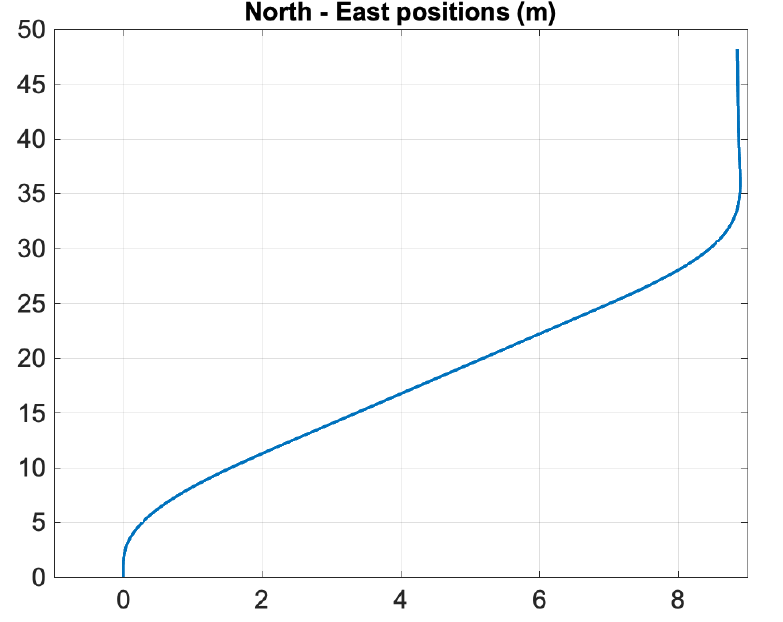
Figure 4. Simulation study: North–East positions of the USV for a 20 degrees course command, which is changed back to 0 degrees at time t = 20 s.